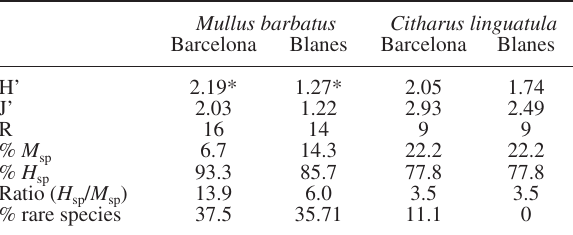
Table 5. – Parasite diversity (H’), evenness index (J’), species rich- ness (R) of parasites, distribution of monoxenous ( M enous ( H ) parasite species, and percentage of rare species (P<5%) sp in Mullus barbatus and Citharus linguatula from each location. * Significant differences between